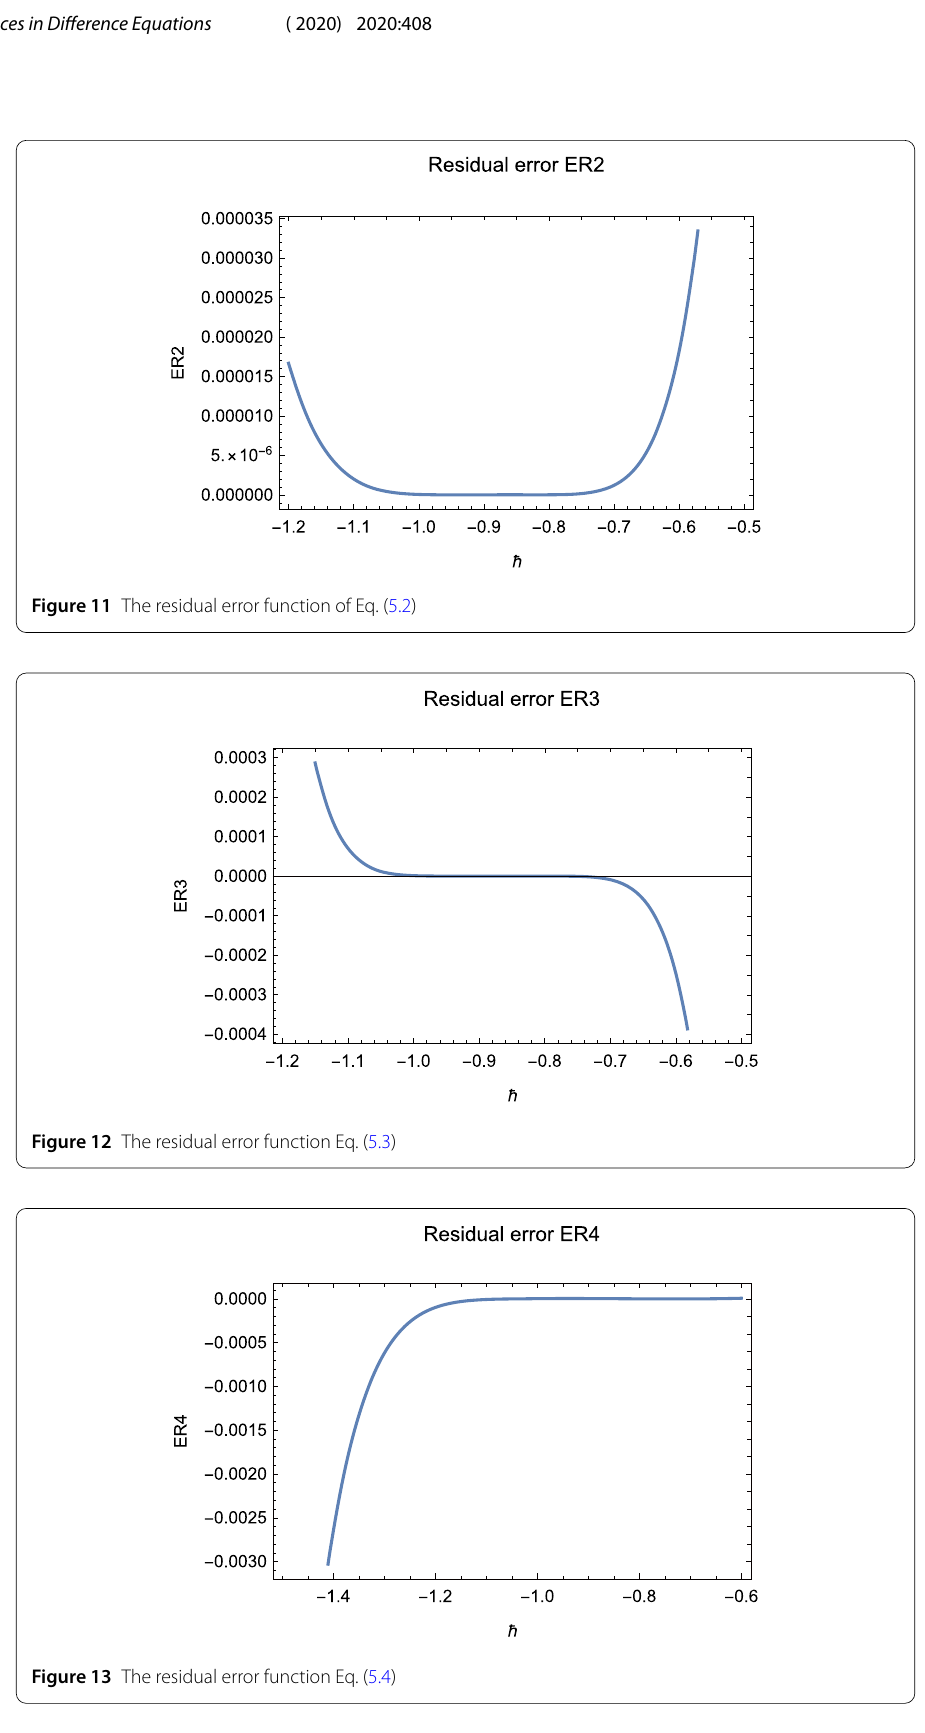
Figure 13 The residual error function Eq.